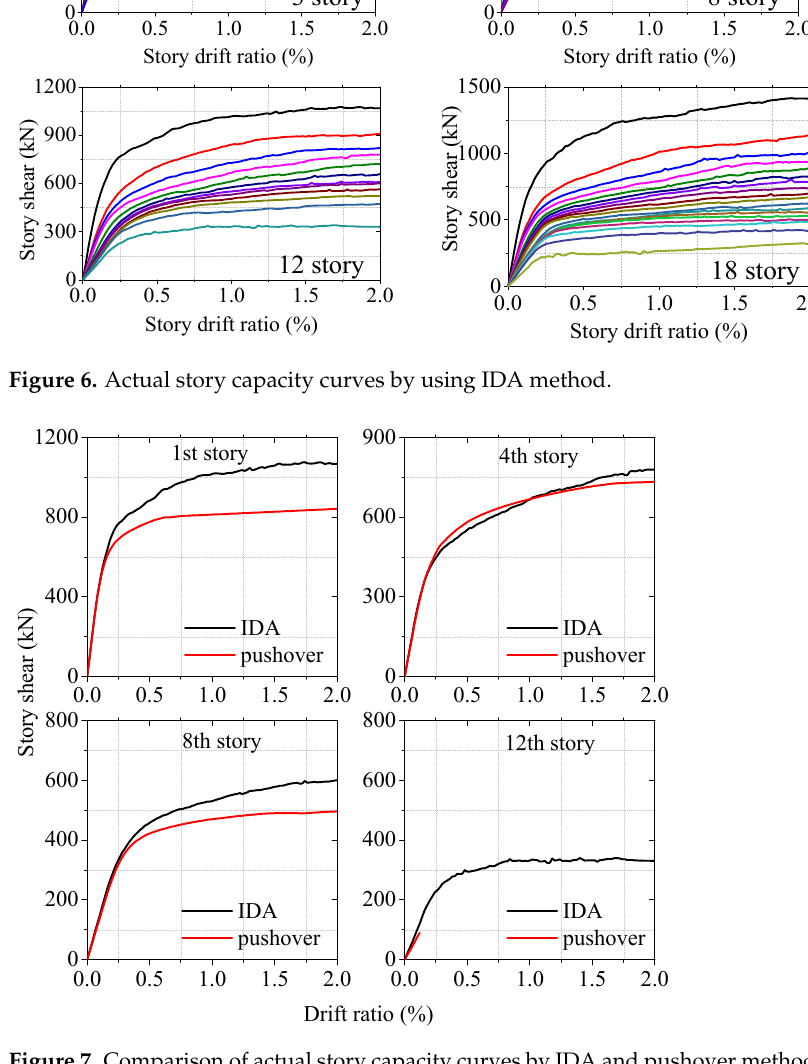
Figure 7. Comparison of actual story capacity curves by IDA and pushover methods (using a 12-story frame as an example).